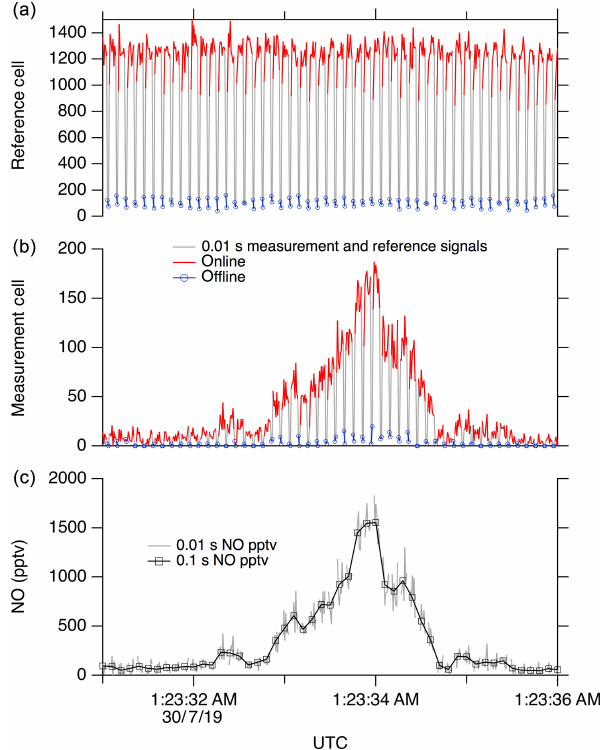
Figure 9. A 5s segment of typical data. (a) shows signal in the reference cell, and (b) shows the signal in the measurement cell. (c) shows calculated NO at 10Hz.